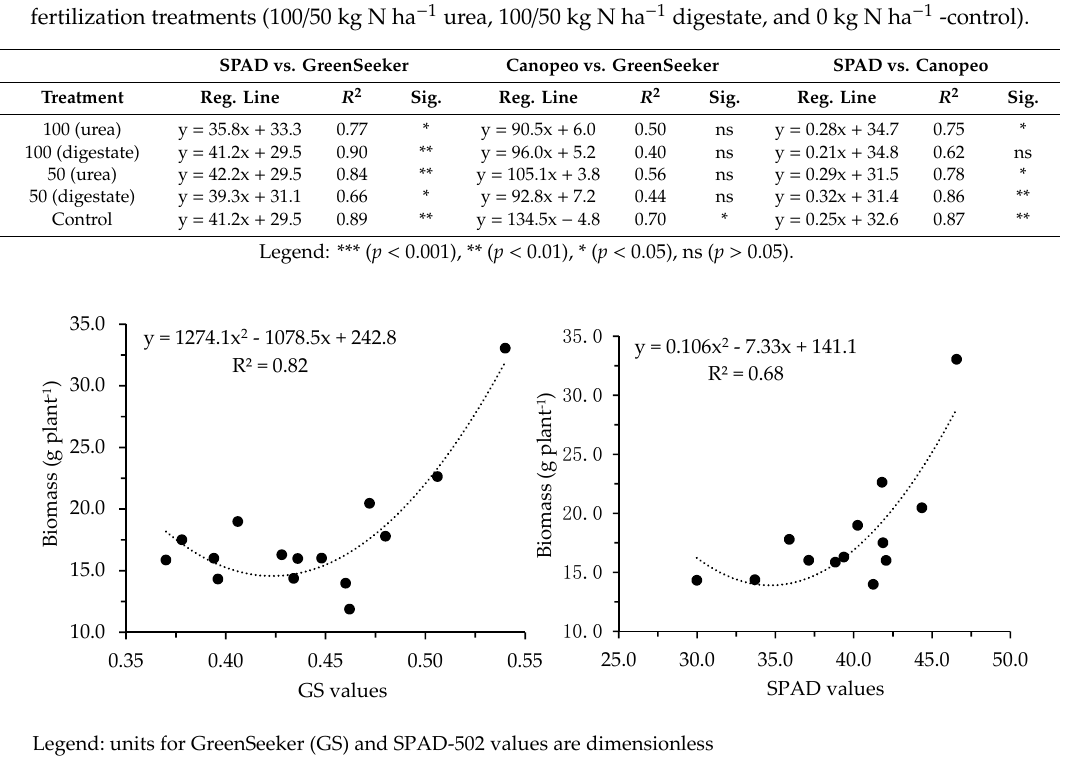
Figure 6. Polynomial regression between SPAD-502 (at 70 DAS) and GreenSeeker-GS (at 84 DAS) observations with biomass at harvesting (at 110 DAS).